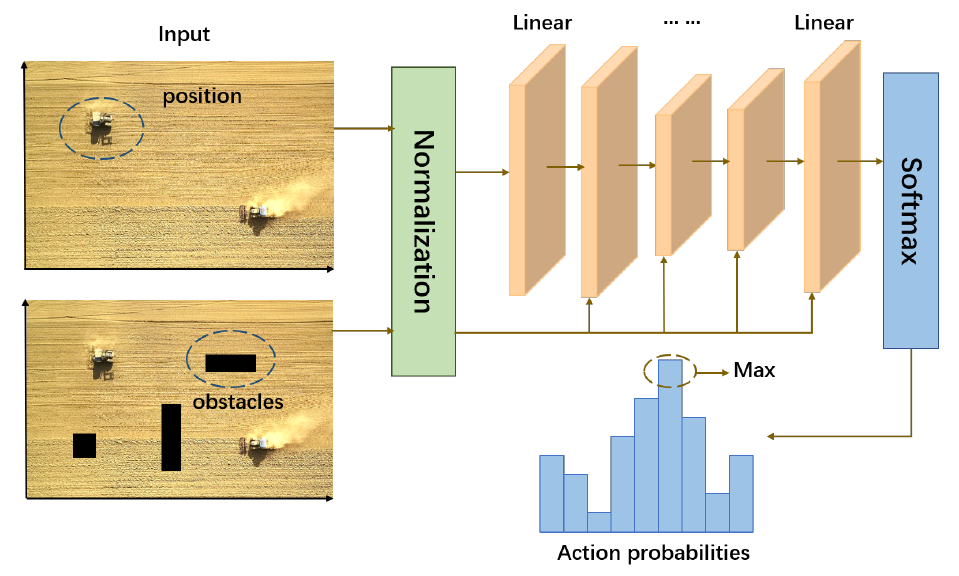
Figure 3. The residual-like network used in reinforcement